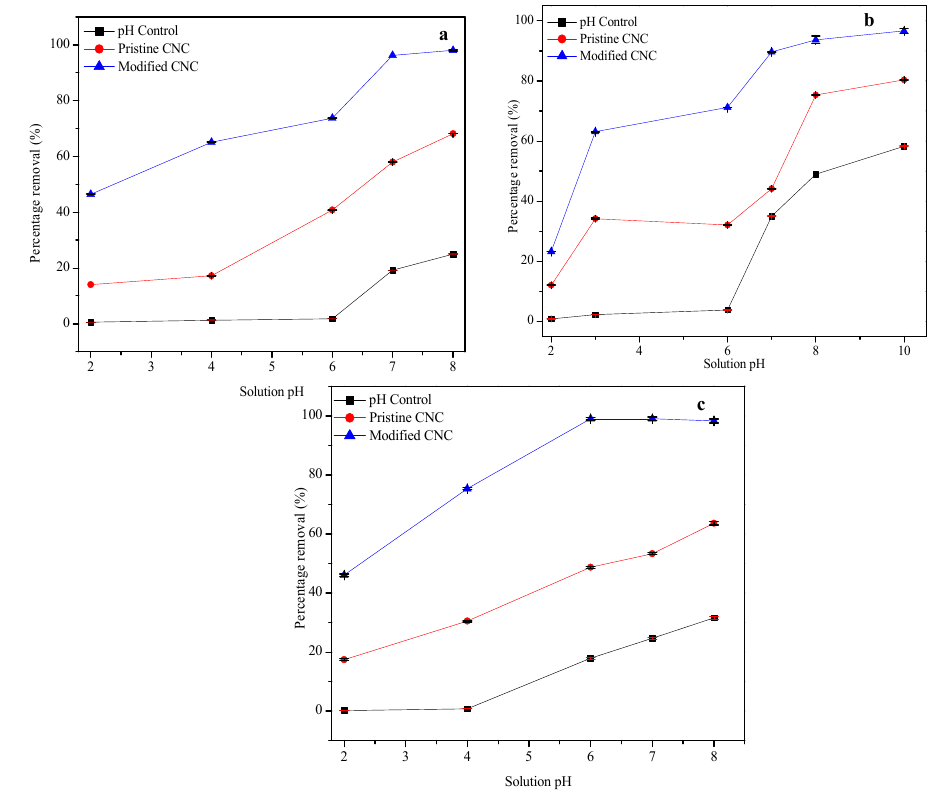
Figure 5. Effects of solution pH on trace metals removal from aqueous solution: ( a ) Cu ( b ) Fe ( c ) Pb (coagulant dosage 5 mg/L, initial concentration 20 mg/L, volume 1000 mL).